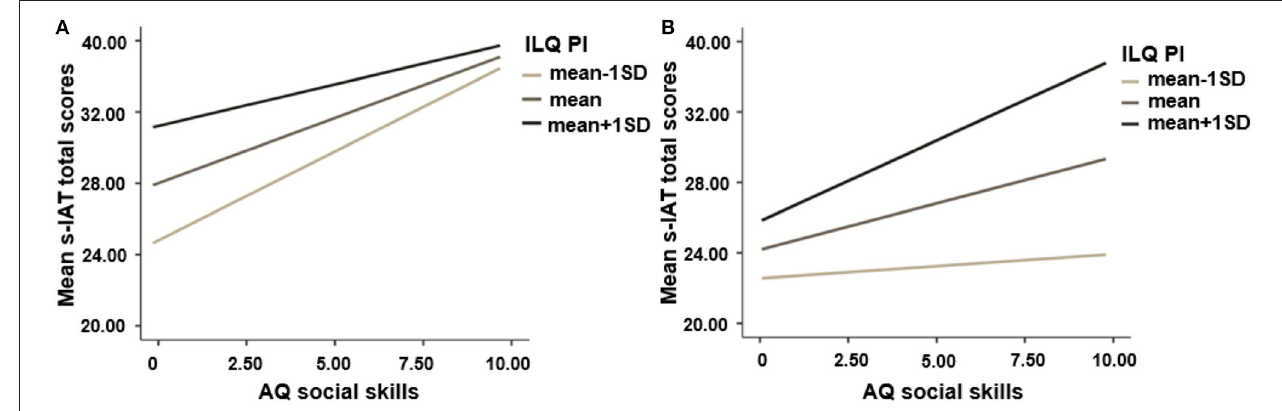
FIGURE 3 | Simple slopes to illustrate the interaction effect between social skills of autistic traits and Internet Literacy production and interaction dimension on s-IAT total scores. (A) Chinese sample; (B) German